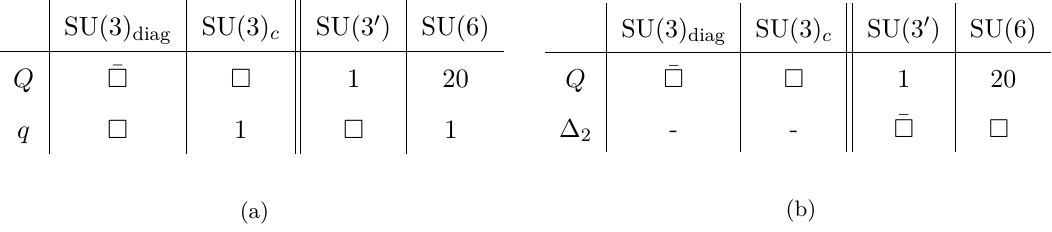
Table 1 . New field content in the two models (a) M1, KSVZ-like and (b) M2, DFSZ-like used to solve the θ 0 parameter in the SU(6) × SU(3) 0 color unification model from ref. [1]. Both Q and q are massless and are part of the exotic quark condensate, while ∆ 2 has a vev h ∆ i = Λ CUT . Compared to the original nomenclature in ref. [1], we identify Q = ψ L and q = χ